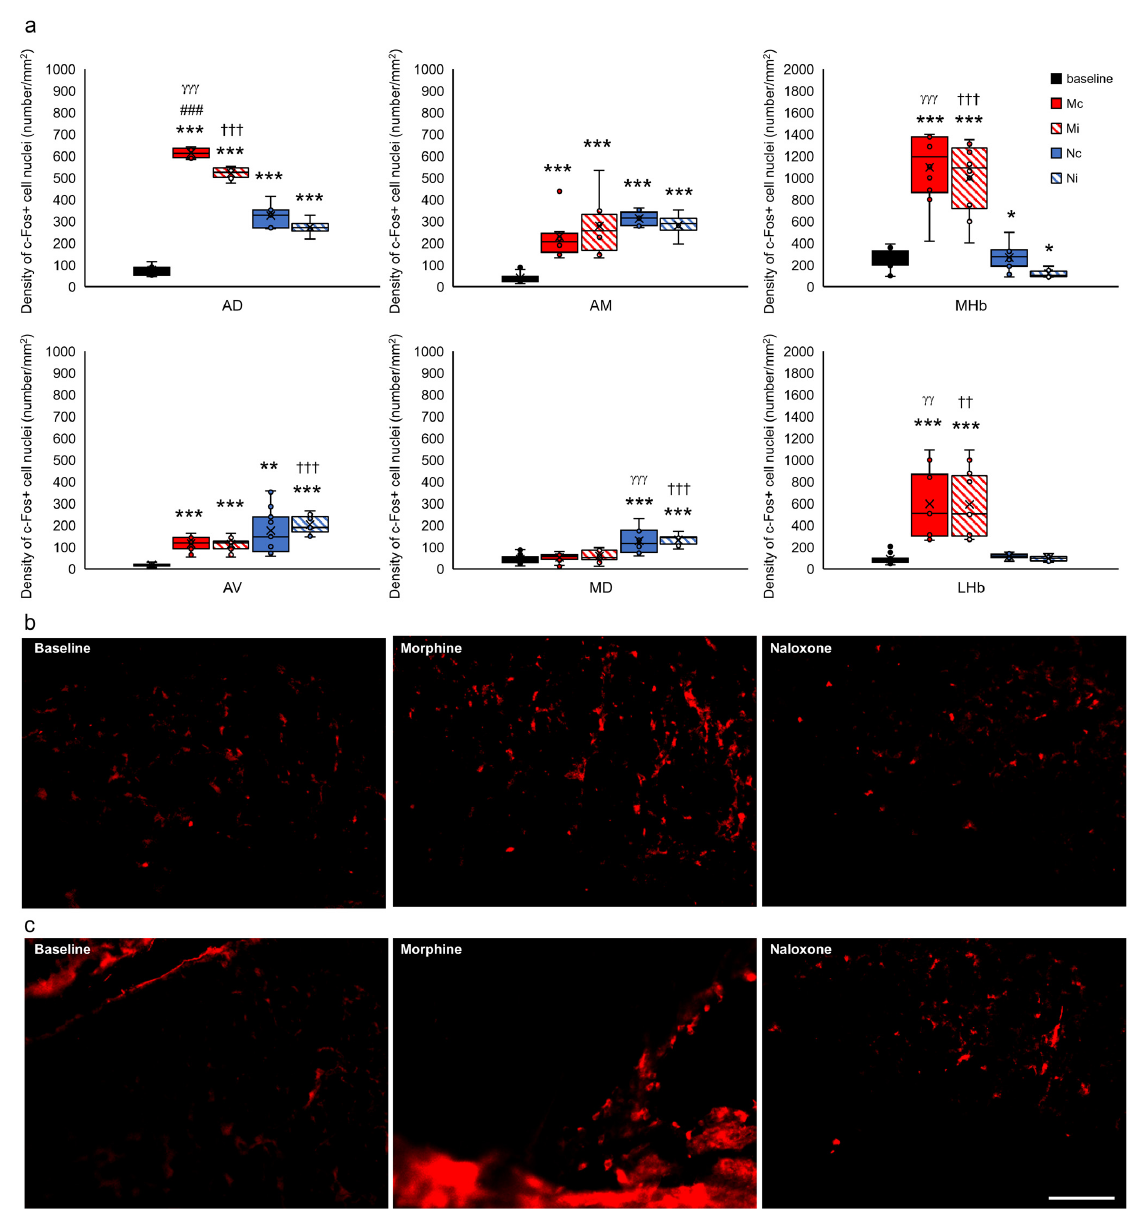
Figure 9. Density of c-Fos+ cell nuclei (number/1 mm 2 ) in select limbic structures of the thalamus in the brains of rats that were subjected to VTA electrical stimulation (Es-VTA) only (baseline group, n = 5) (black-filled bars) and in the brains of rats administered Es-VTA and a one-time injection of morphine (1.5 µ g) or naloxone (25.0 µ g) injected into the PPN in the contralateral (Mc, n = 5, red-filled bars; Nc, n = 6, blue-filled bars) and ipsilateral hemispheres (Mi, n = 5, red-hatched bars; Ni, n = 6, blue-hatched bars) ( a ). Representative photomicrographs of c-Fos-labeled neurons in the LHb ( b ) and MHb ( c ) structures are shown. Scale bar = 100 µ m (white line: right lower corner of the last photo, panel ( c )). Tukey’s post hoc test: * p < 0.05, ** p < 0.01, and *** p < 0.001 indicate a significant difference between the baseline and other experimental groups (Mc, Mi, Nc, and Ni groups); ### p < 0.001 indicate a significant difference in the morphine groups between different injection site: contra- or ipsilateral hemispheres (Mc vs. Mi group); γγ p < 0.01, γγγ p < 0.001 indicate a significant difference in the contralateral side groups between different injection drug: morphine or naloxone (Mc vs. Nc group); †† p < 0.01, ††† p < 0.001 indicate a significant difference in the ipsilateral side groups between different injection drug: morphine or naloxone (Mi vs. Ni